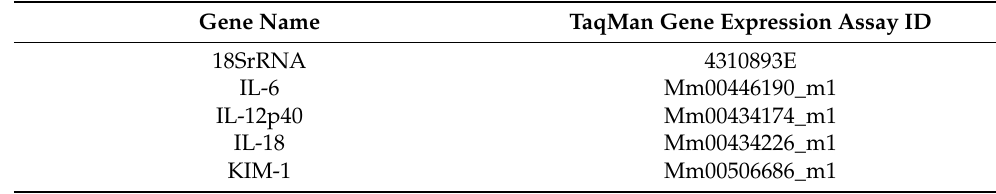
Table 2. Primer sequences (TaqMan Gene Expression Assay) for analysis of mRNA